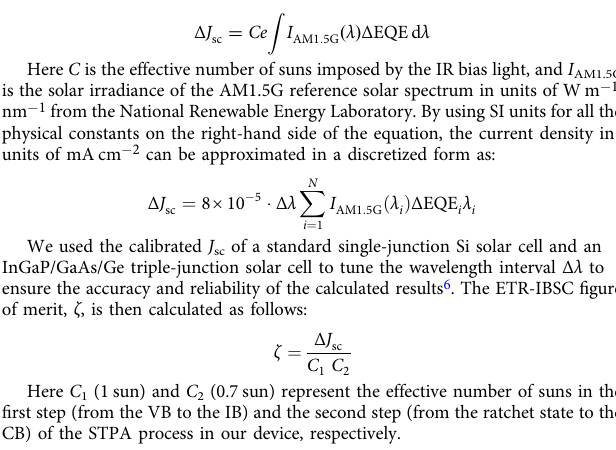
Figure-of-merit calculation . The enhancement of the short-circuit current density via STPA, Δ J sc , is calculated from the Δ EQE spectrum at each temperature in order to evaluate the effect of the ETR on the IBSC device